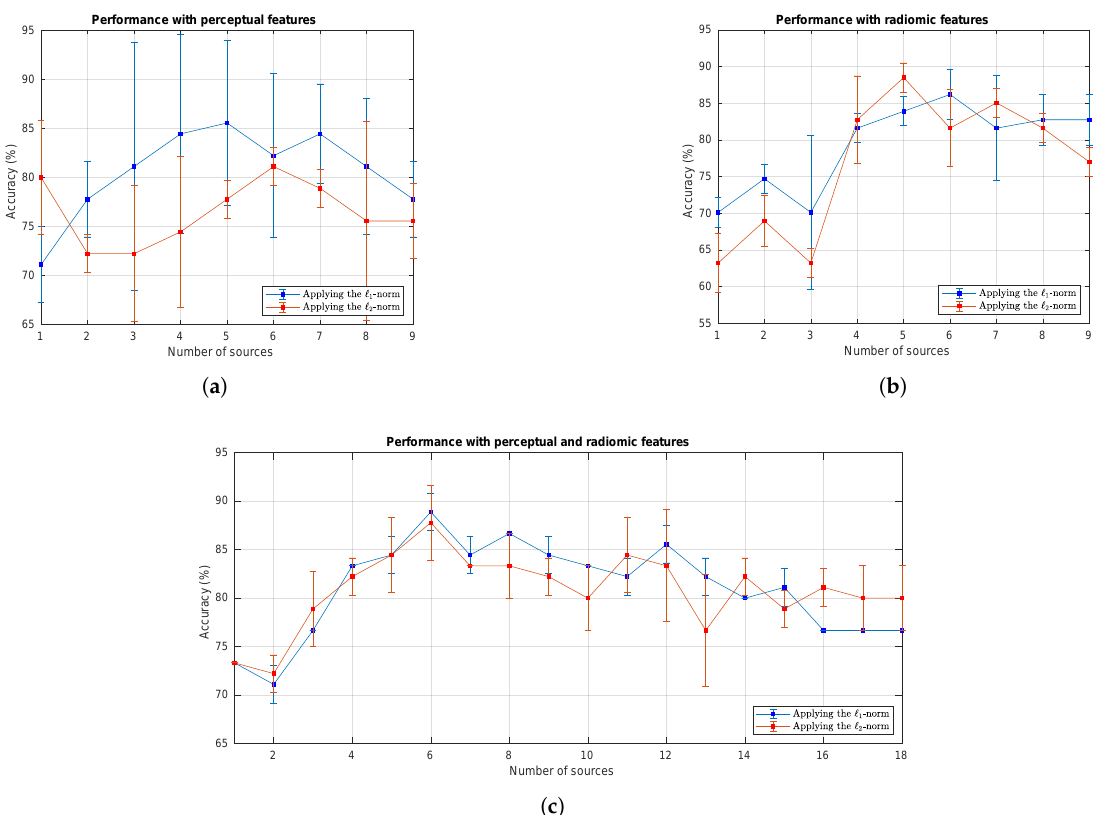
Figure 5. Performance curves obtained with the test dataset when the number of MRI sequences was reduced. ( a ) Performance curves using only the perceptual features; ( b ) Performance curves using only the radiomic features; ( c ) Performance curves using both perceptual and radiomic